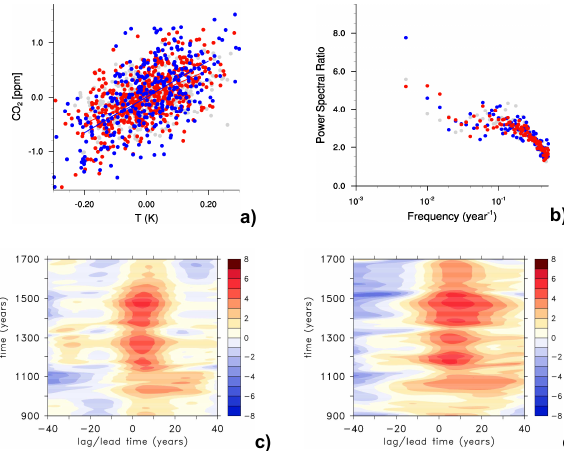
Fig. 8. Climate carbon-cycle sensitivity: (a) Co-variability of an- nually averaged NH temperature anomalies with globally and an- nually averaged CO 2 anomalies for the ensemble E1 (red dots), the ensemble E2 (blue dots) and control (grey dots) experiments. Data points are taken by randomly sampling the low-pass (31-year) fil- tered data with a mean sample stride of 16 years. Correlations are significant at greater than the 99% level given an equivalent sam- ple size of 179, 230 and 85 for the control and ensemble E1 and E2 respectively (see Appendix C), ( b) Ratio of power spectra as a function of wave-number for the E1 (red) and E2 (blue) ensem- bles and the control (grey) simulations. In both panels the forced experiments were analyzed for the period between 800 and 1700, during which time the anthropogenic influence on the carbon cycle was negligible, (c), and (d) running regressions (slopes in ppm/K) between NH temperature anomalies and globally and annually av- eraged CO 2 anomalies for different time lags (positive lags mean that temperature is leading) for the ensemble means of ensemble E1 (left) and E2 (right). Running regressions were performed over 200-yr windows based on the 31-yr low-passed filtered